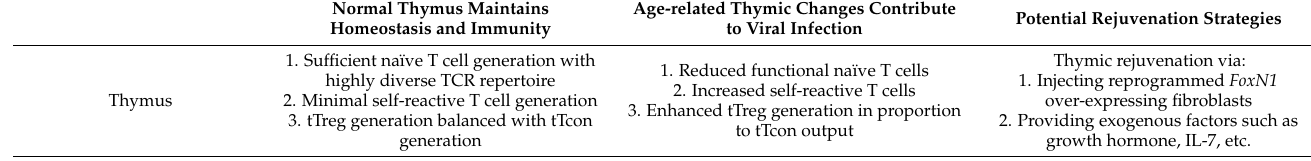
Table 1. Contributions of aged thymus to viral infection and potential rejuvenation therapeutics. Normal Thymus Maintains Age-related Thymic Changes Contribute Homeostasis and Immunity to Viral Infection Potential Rejuvenation